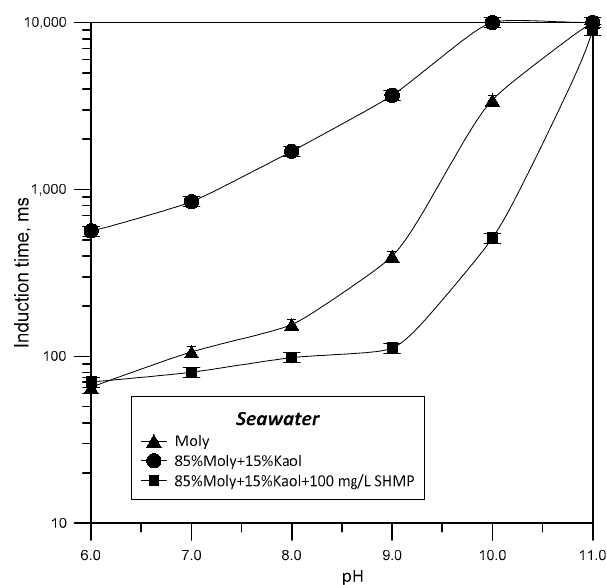
Figure 4. Induction times obtained at different pH in seawater, using particle beds of molybdenite, 85% molybdenite + 15% kaolinite without SHMP, and 85% molybdenite + 15% kaolinite in the presence of 100 mg/L of SHMP. Moly: molybdenite; kaol: kaolinite.